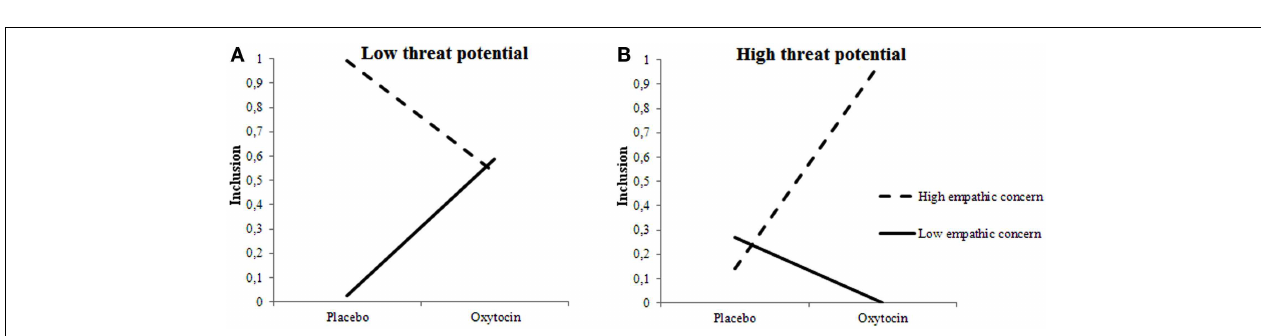
FIGURE 1 | Fetal testosterone exposure moderates effects of oxytocin on inclusion decisions. Low-threat targets [ (A) examples in bottom left panel] are preferred less and high-threat targets [ (B) examples in bottom right panel] are preferred more by individuals with high fetal testosterone vs. estradiol exposure when given oxytocin